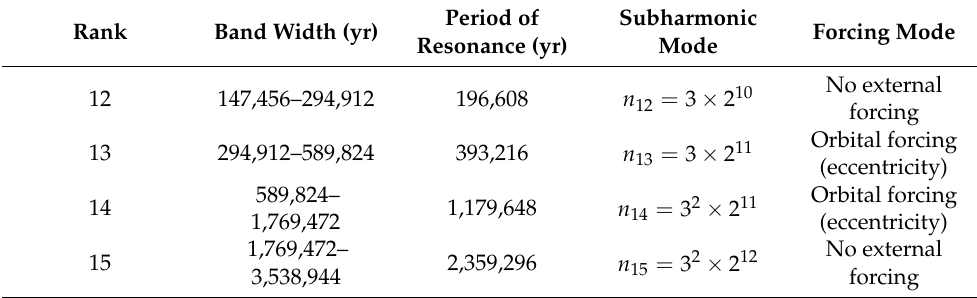
Table 1. The natural periods of Gyral Rossby Waves (GRWs), and the bands characteristic of subharmonic modes. Each subharmonic mode is built by recurrence from the observations as indicated in the introduction. Previous modes were defined in